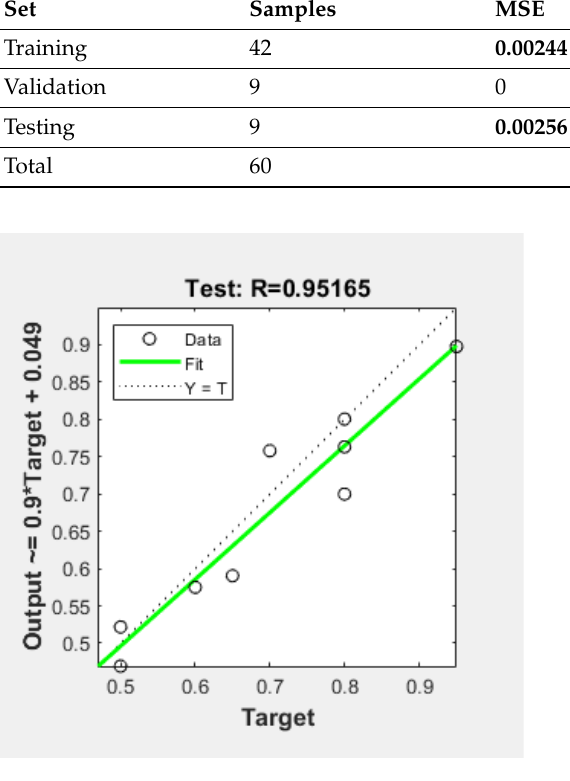
Table 3. Sample size and composition.